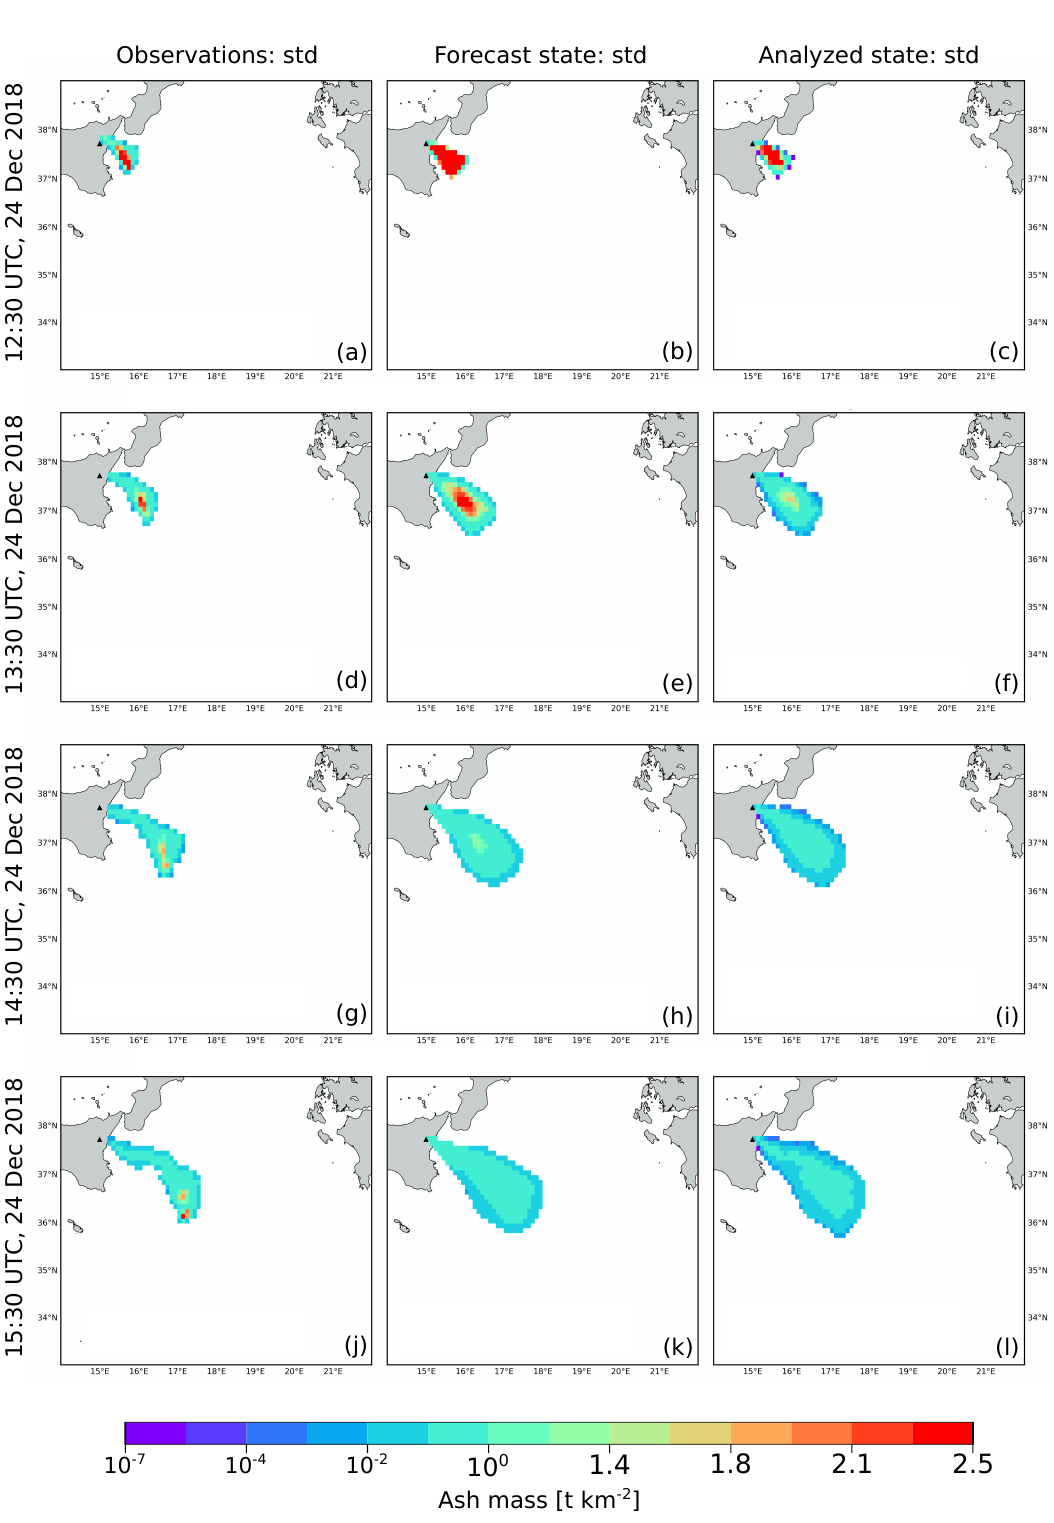
Figure 7. Standard deviations of ash columnar content resulting from EXP1. Figure layout is the same as Figure 5, while color bar scale has an upper limit of 2.5 t km − 2 instead of 5 t km − 2 as in Figure 5. Panels ( a , d , g , j ) show the observation error (Observations: std). Panels ( b , e , h , k ) illustrate the standard deviation of ash columnar content as predicted by the numerical model PLUME-MoM&HYSPLIT (Forecast state: std), while Panels ( c , f , i , l ) present the standard deviation resulting from of the assimilation cycles (Analyzed state: std). Results of assimilation cycles performed at 12:30, 13:30, 14:30 and 15:30 are